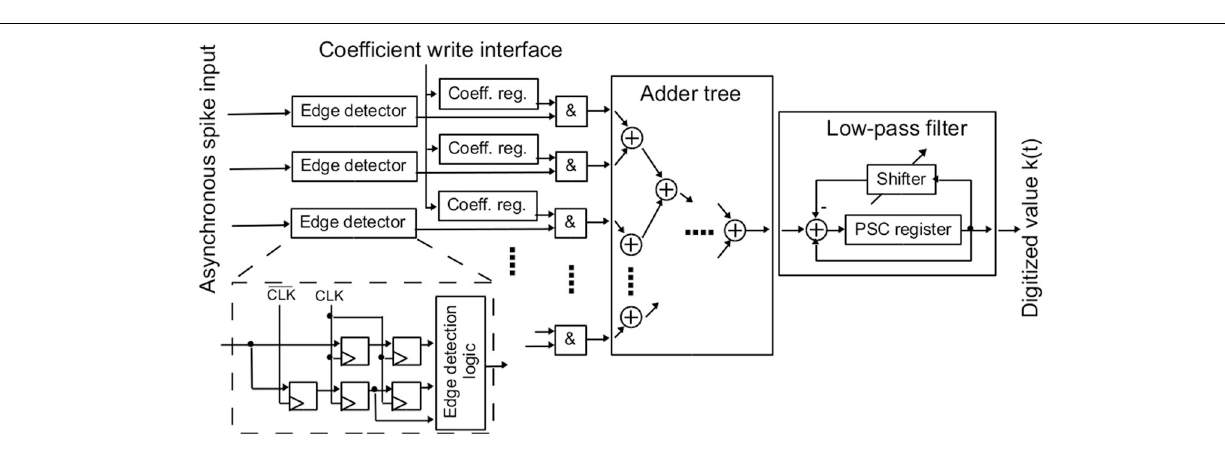
FIGURE 5 | Digital synchronous pulse registration, adder tree and low-pass